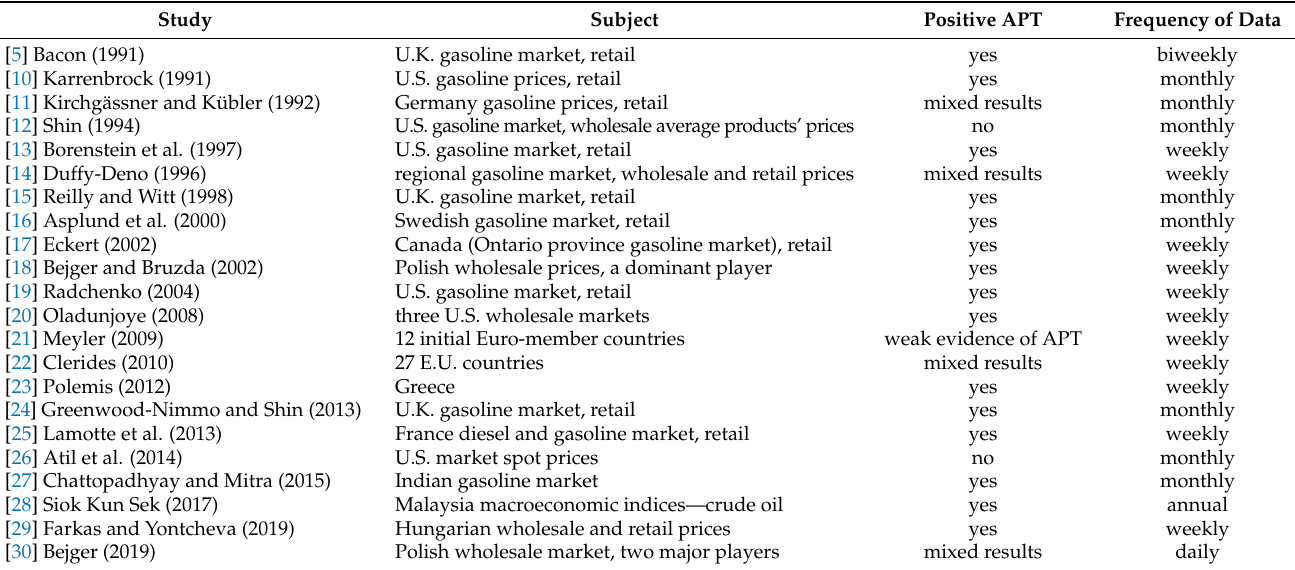
Figure 2. Pattern asymmetry. Table 1. Selected APT studies on liquid fuel